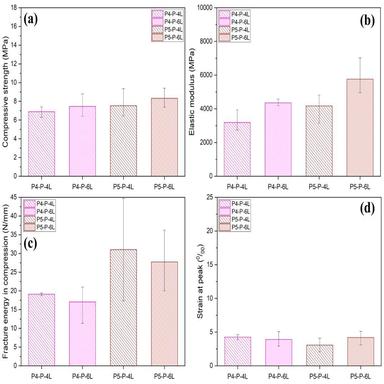
Mean values of compressive strength (a), elastic modulus (b), fracture energy in compression (c) and strain at peak (d) for prims extracted from P4 and P5.